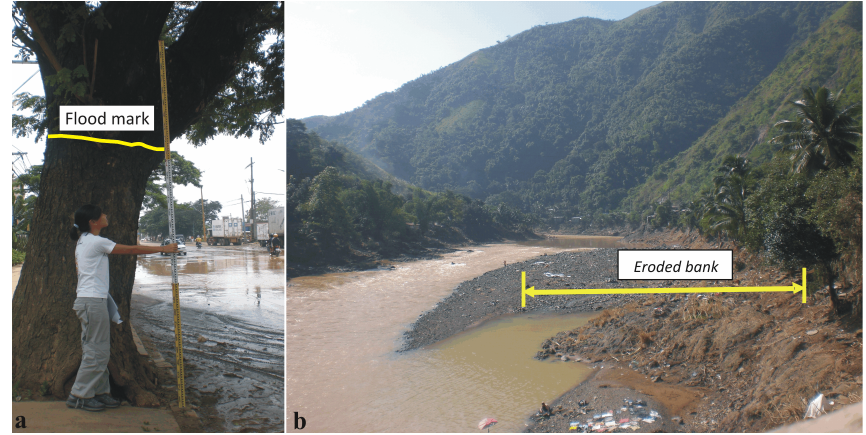
Fig. 3. (a) Photo taken along JP Rizal Avenue showing mud (stain) deposits on the bark of the tree indicating flood height and; (b) photo of upstream Marikina River showing extensive bank erosion.